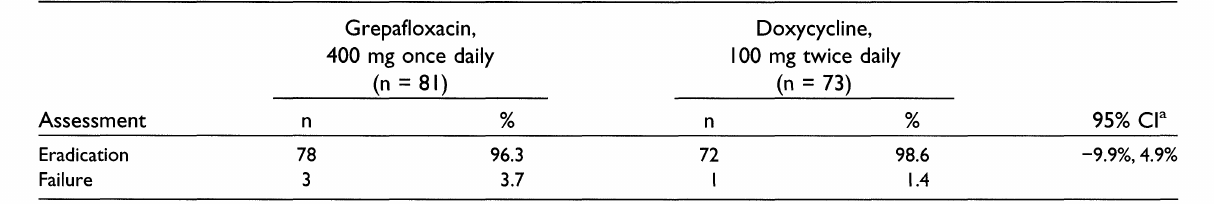
TABLE 4. Clinical response rates at the 21-28 day posttreatment visit